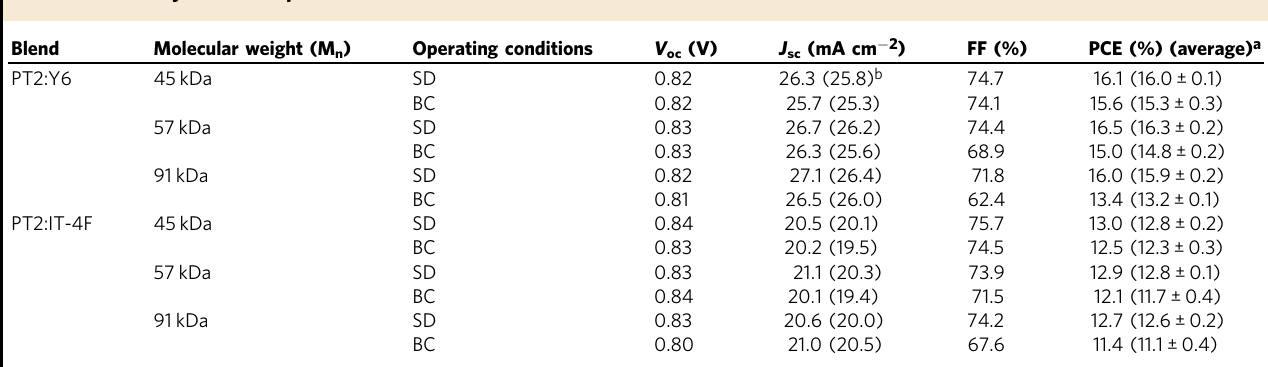
a The average parameters were calculated from 10 independent